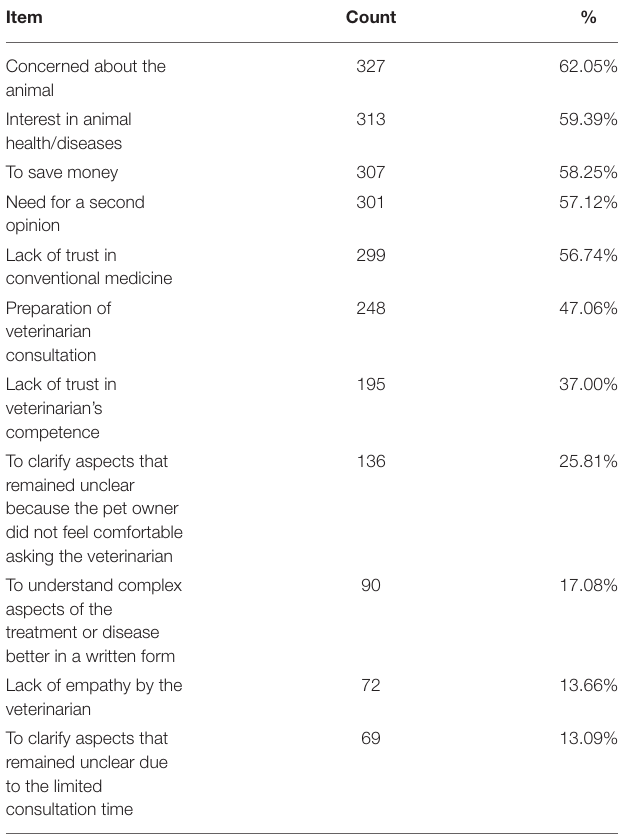
TABLE 4 | Frequencies of the questionnaire items related to reasons that owners sought self-information from a survey of 527 German